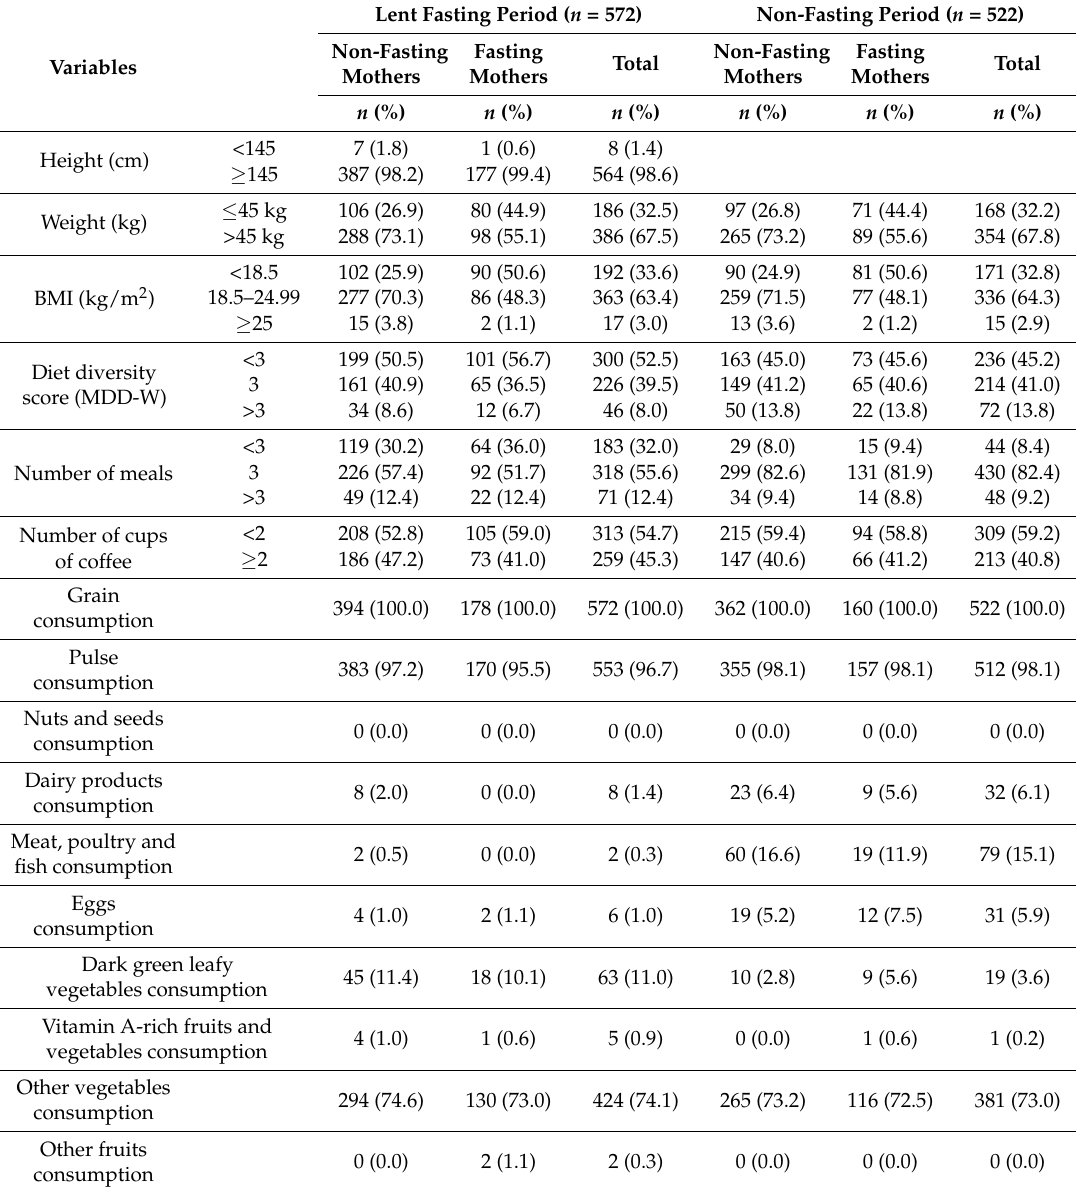
Table 4. Food consumption and anthropometric status of lactating mothers during Ethiopian Orthodox lent fasting and non-fasting periods at rural Tigray, Northern Ethiopia. Lent Fasting Period ( n = Variables